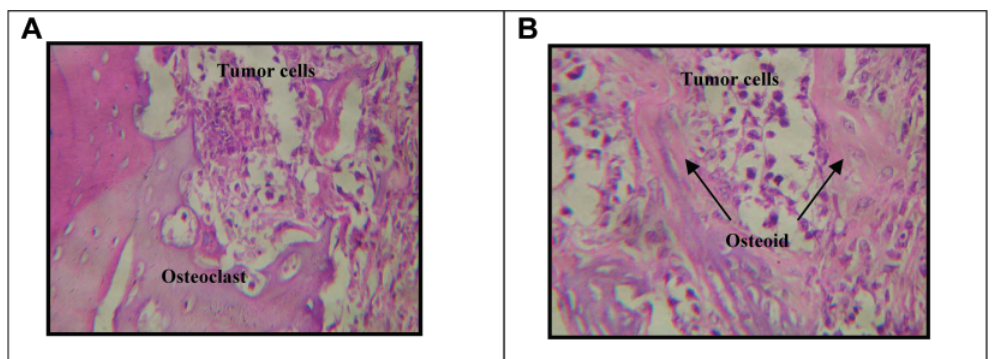
FIGURE 3 - A) Photomicrograph of Walker 256 Carcinosarcoma from the alendronate treated group displaying malignant mesenchymal cells and bone trabeculae with osteocytes and osteoclasts. HE 400X. B) Trabeculae of osteoid tissue alongside with undifferentiated malignant cells. HE 400X. TABLE 2 - Results from the evaluation of the post- chemotherapy index with